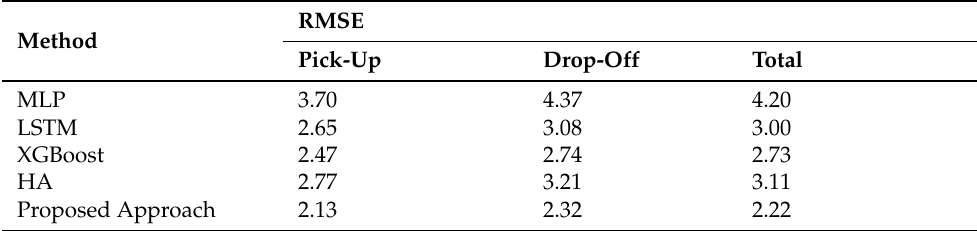
Table 4. Comparison of various methods